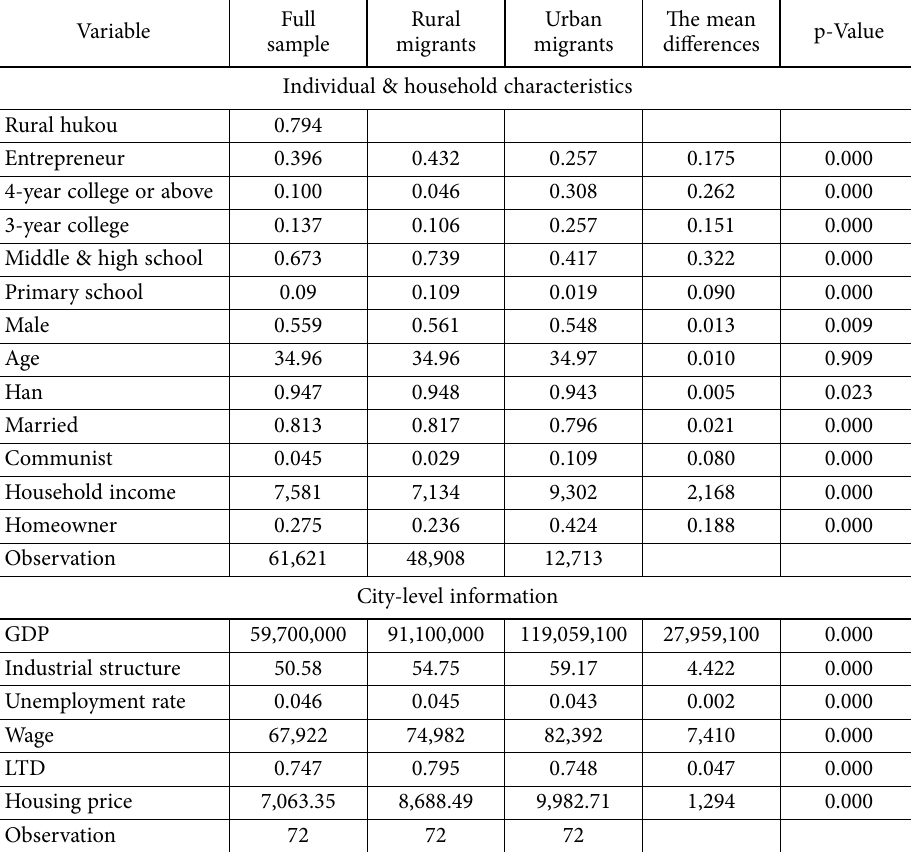
Table 1. Summary statistics (source: Individual and household data are obtained from the National Health Commission of China, 2016; City-level data are obtained from National Bureau of Statistics of China, 2017)